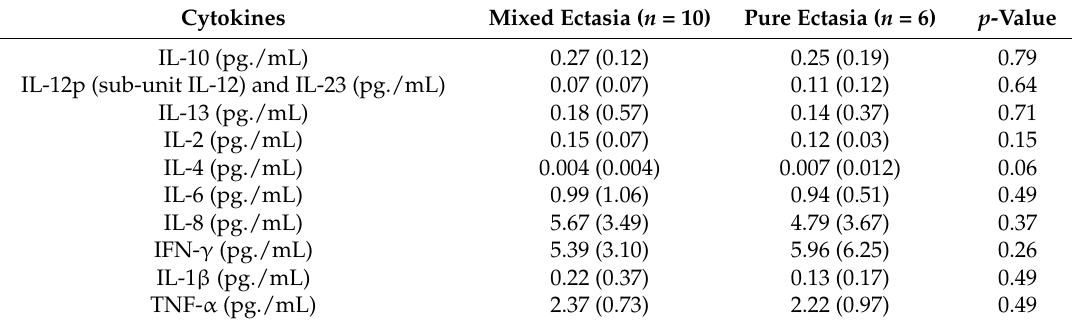
Table 3. Immuno-inflammatory response and related cytokines levels in CAE sub-groups of pure versus mixed ectasia. Data is presented as median (interquartile range) and p -values derived from Mann–Whitney U -tests. Cytokines Mixed Ectasia ( n = 10) Pure Ectasia ( n = 6) p -Value IL-10 (pg./mL) 0.27 (0.12) 0.25 (0.19) 0.79 IL-12p (sub-unit IL-12) and IL-23 (pg./mL) 0.07 (0.07) 0.11 (0.12) 0.64 IL-13 (pg./mL) 0.18